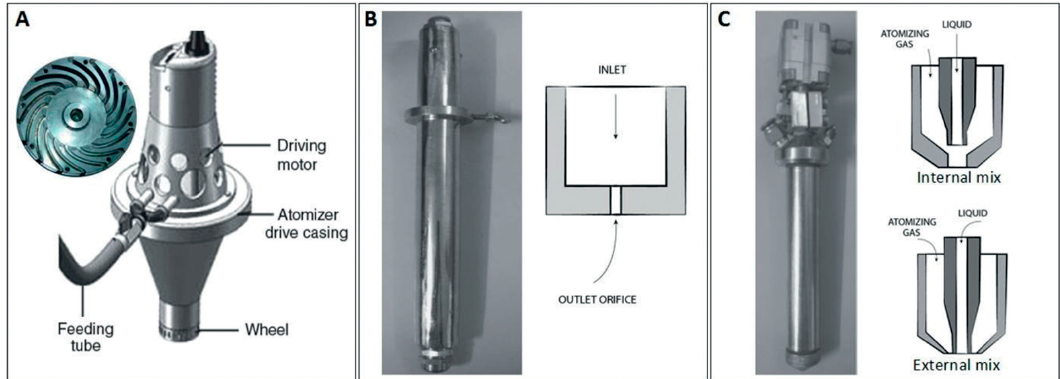
Figure 4. Schematic representation of atomizers used in: ( A ) rotary atomization, ( B ) hydraulic atomization and ( C ) pneumatic atomization; reproduced from [15].